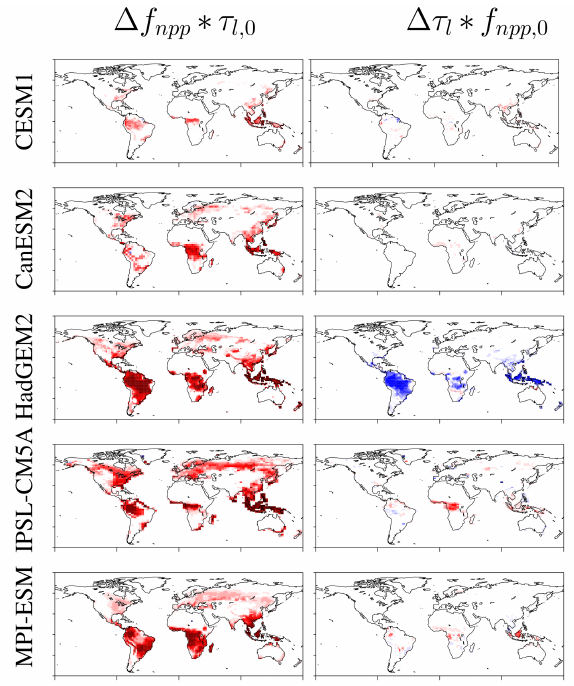
Figure 5. Responses of linearized equilibrium live carbon pools (kgCm − 2 over the interval of CO 2 doubling) in biogeochemically coupled (esmFixClim1) run. Left column shows productivity-driven changes to b C l . Right column shows turnover-driven changes to b C l